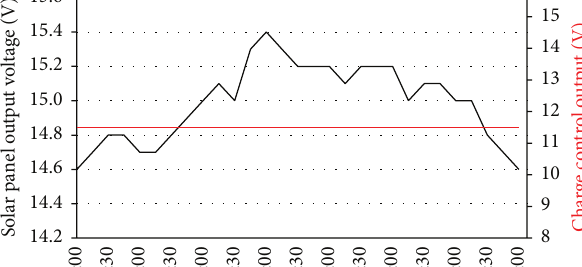
Figure 7: Hourly solar radiation and temperature changes in the experimental period.